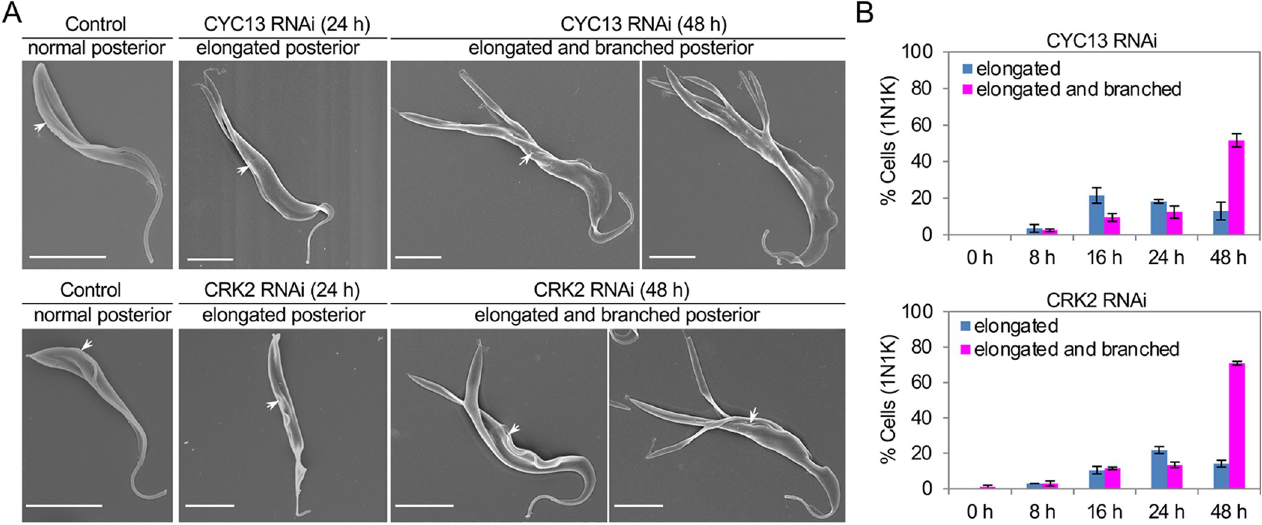
Fig 1. Knockdown of CYC13 or CRK2 causes posterior elongation and branching in the procyclic form of T . brucei . ( A ). Scanning electron microscopic analysis of non-induced control, CYC13 RNAi-induced cells, and CRK2 RNAi-induced cells. The white arrows indicate the position of the flagellum pocket. Scale bars: 5 μ m. ( B ). Quantitation of cells with an elongated posterior or an elongated and branched posterior of non-induced and RNAi-induced cells of the CYC13 RNAi cell line and the CRK2 RNAi cell line. 100 1N1K cells for each time point were used for measurement of the posterior length (K-to-P) and counted. Error bars indicate S.D. from three independent biological